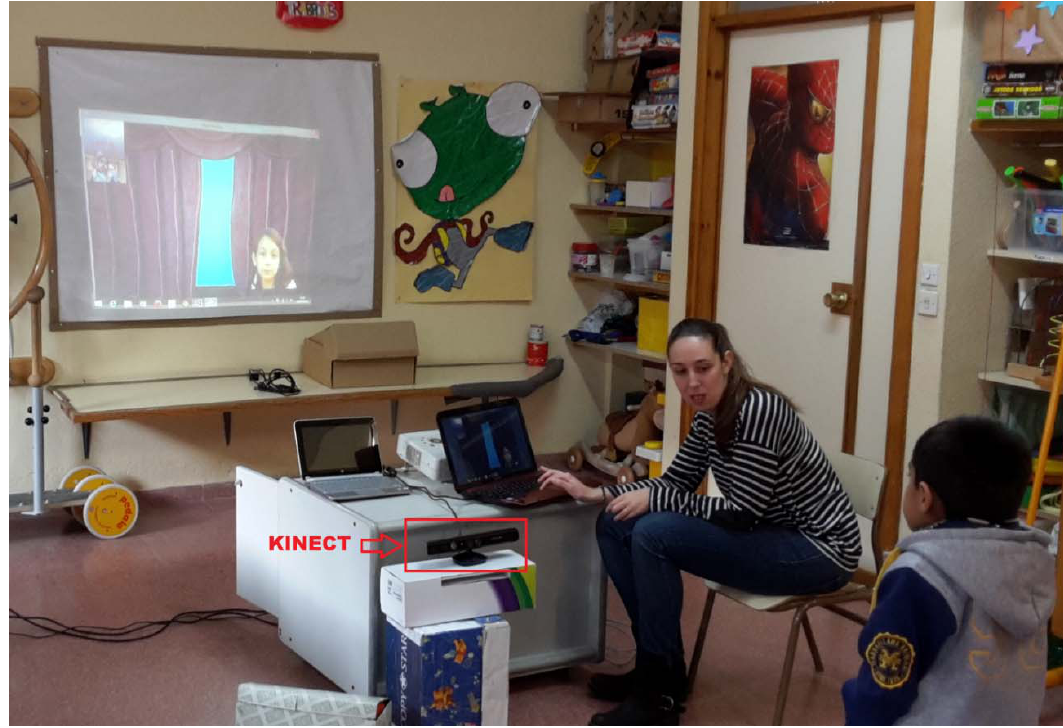
Figure 13. SONRIE validation stage.